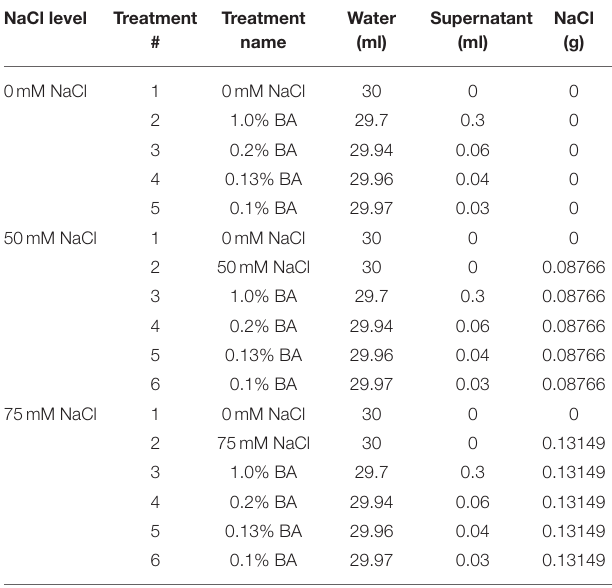
TABLE 1 | Quantity of water, microbial cell-free supernatant and NaCl, mixed together to obtain 30mL of each treatment.